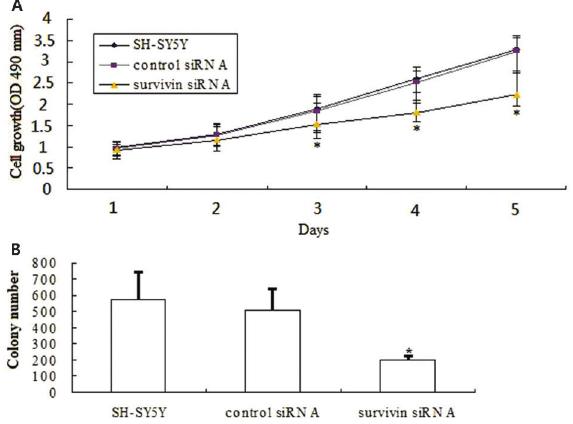
Figure 3. Influence of survivin knockdown on cell growth and colony number. A , MTT assay was analyzed for SH-SY5Y cells left untreated, transfected with survivin siRNA, and transfected with control siRNA on days 1, 2, 3, 4, and 5. B , Soft agar assay was assessed to evaluate the colony-forming ability of the cells. Data are reported as means±SD. *P , 0.05 compared with untreated SH-SY5Y or control siRNA-transfected cells (Mann- Whitney U-test).